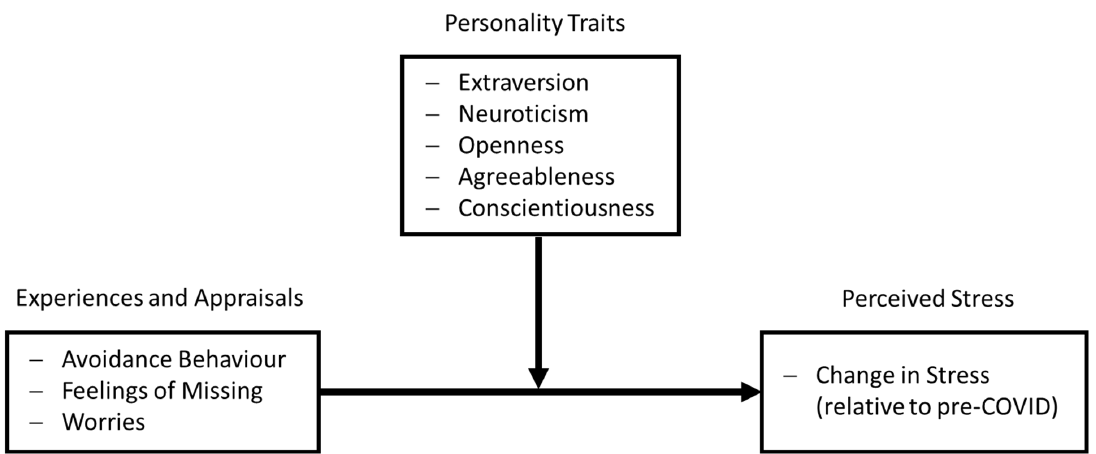
Figure 1. Schematic model of the assumed association between COVID ‐ related experience and appraisals, personality traits, and changes in perceived stress.